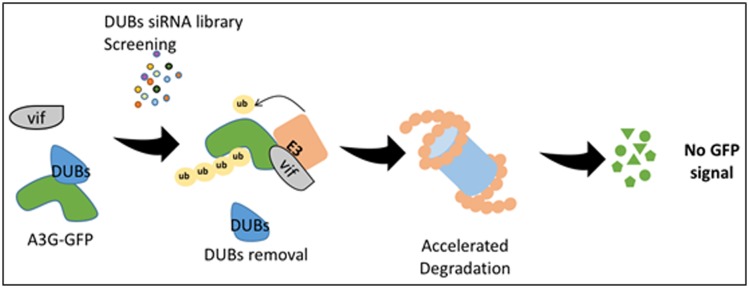
The schematic of high-throughput screening.